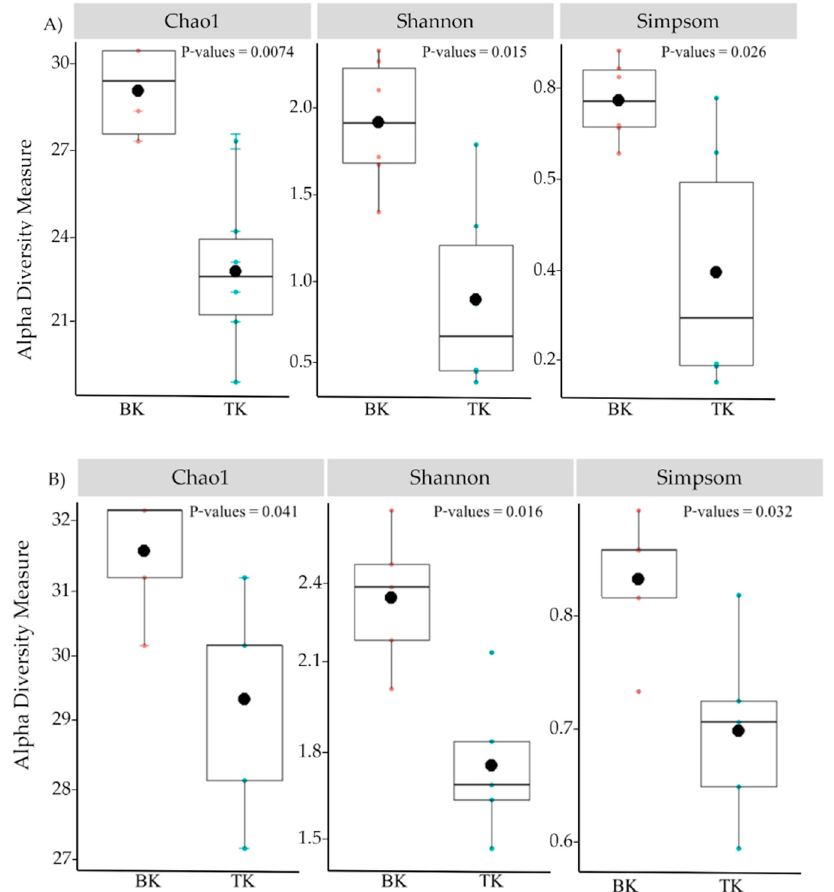
Figure 5. Alpha diversity of bacteria ( A ) and Fungi ( B ) of mural paintings according to Chao1, Shannon and Simpson indices in samples collected from Buak Krok Luang Temple (BK) and Tha Kham Temple (TK), black dots and error bar represent the means and Standard deviation of each barplot.